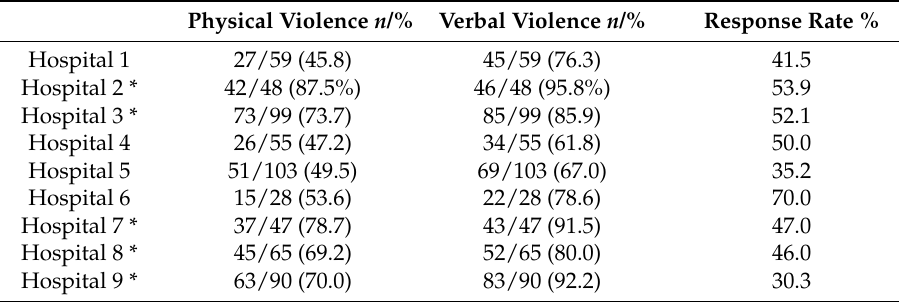
Table 2. Frequencies of physical and verbal attacks for each